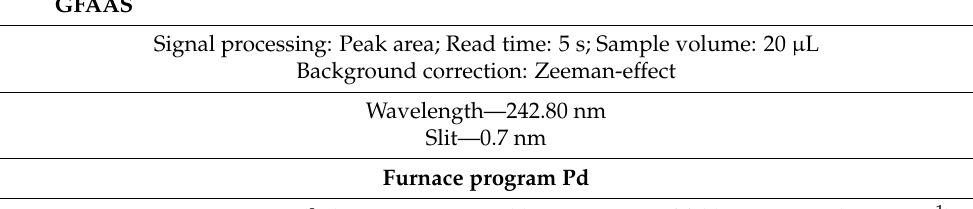
Table 1. Operation conditions for Au determination by graphite furnace atomic absorption spectrometry